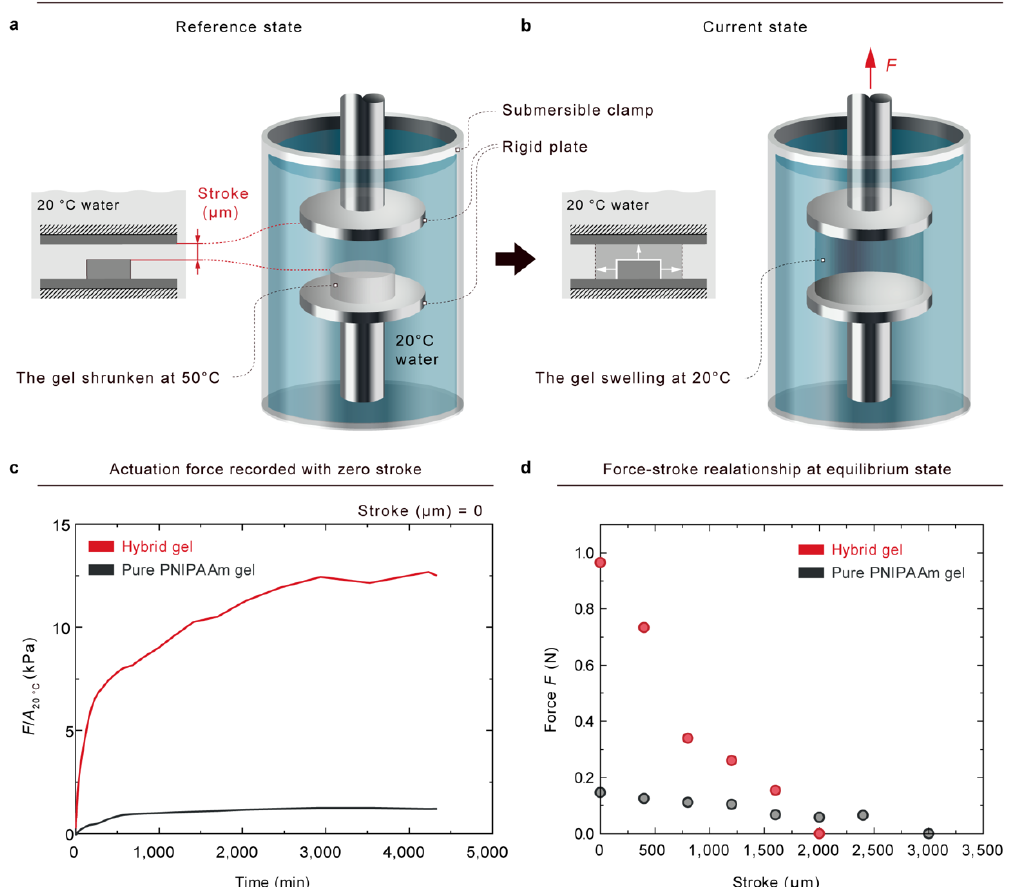
Figure 4. Hybrid gel showing a larger actuation force than pure gel. ( a ) Pure and hybrid gels fully swollen in 20 ℃ water and cut into a disc shape with a diameter of 10 mm. The thicknesses of the pure and hybrid gel were 3.8 mm and 3.4 mm, respectively. The gel was then shrunk in 50 ℃ water for 1 day and placed on a fixed-bottom plate in a submergible clamp kit. An upper plate approached the surface of the gel with a small force of less than 20 µN, and it was lifted from the surface of the gel to create a stroke. The displacements of the upper plate were fixed after giving the stroke between the surface of the hydrogel and the upper plate. The submergible clamp kit was then filled with 20 ℃ water. ( b ) A force, F , was generated by a swelling of the hydrogel due to the phase transition. ( c ) The force divided by the cross-sectional area at 20 ℃ was recorded as a function of time submerged with zero stroke. Hybrid gel shows a maximum force 7 times larger than that of pure gel at equilibrium states. ( d ) Force – stroke curves of pure PNIPAAm gel and hybrid gel.